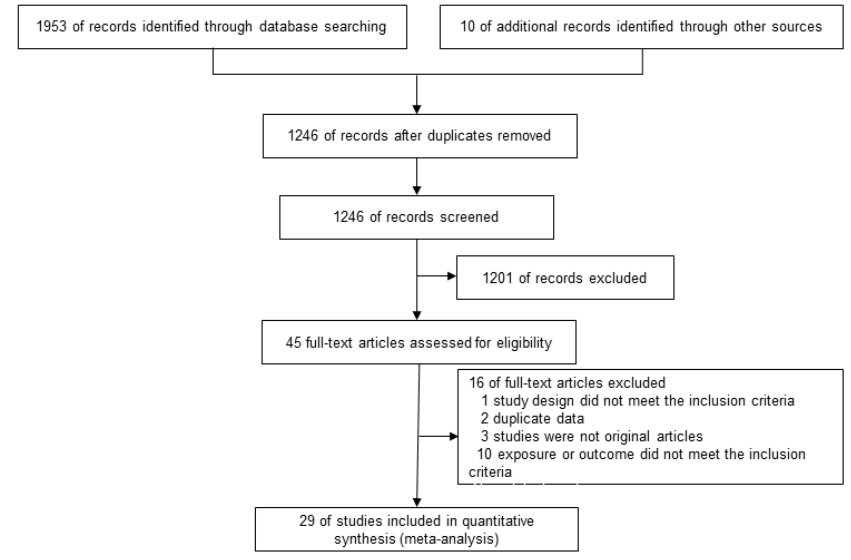
Figure 1. The flow chart of the literature selection.